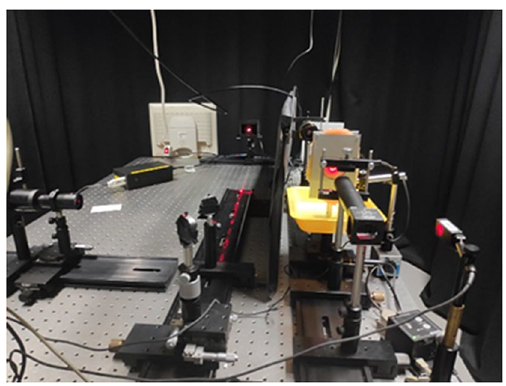
Figure 1. Photo of the experimental